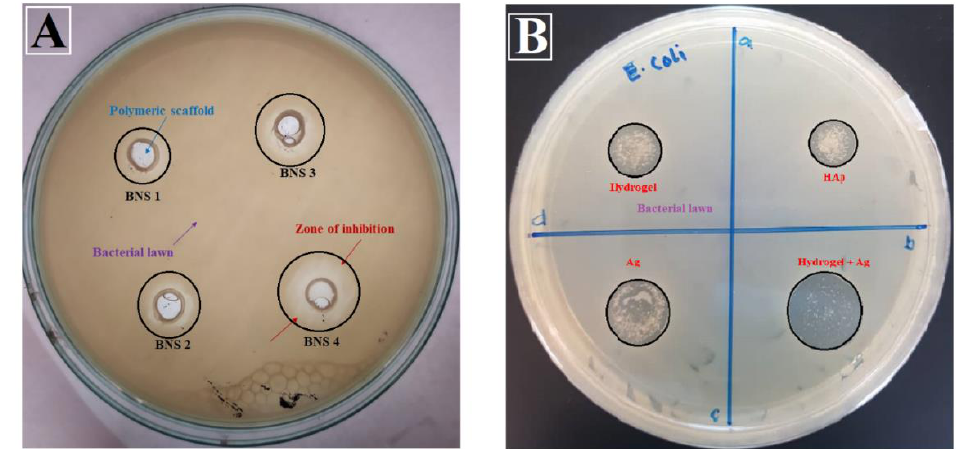
Figure 7. Anti-microbial activities of all scaffold samples ( A ) and individual materials ( B ) against E. coli .